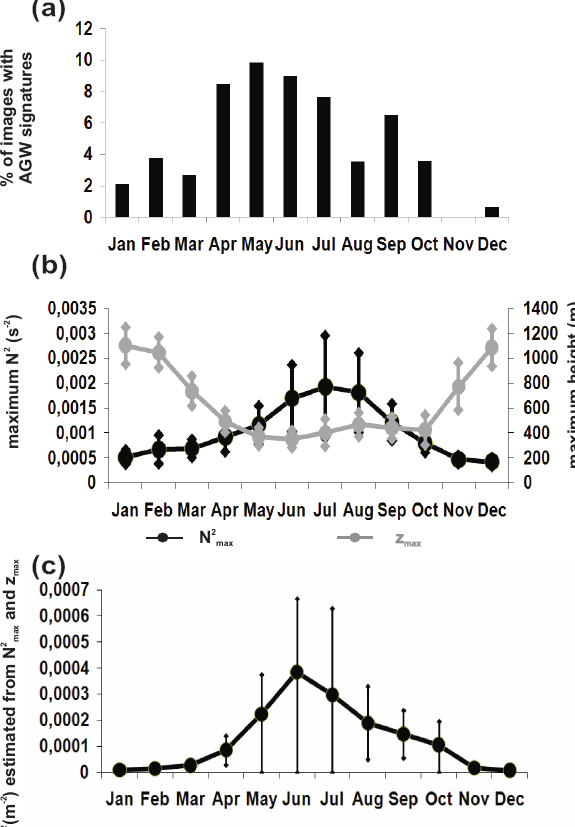
Fig. 4. (a) IW occurrences in Red Sea normalized by number of im- ages per month, for the period between January 1993 and Septem- ber 2008. (b) Monthly averages of stratification taken from Jeddah weather station, between 1993 and 2008, where N 2 max represents the averaged maximum values of N 2 , and z max represents the heights for which N 2 was at its maximum. Error bars show standard de- viations. (c) Monthly averages of the maximum Scorer parameter estimated for the stratification given in (b) (error bars represent vari- ability due to the standard deviations of N max and z max